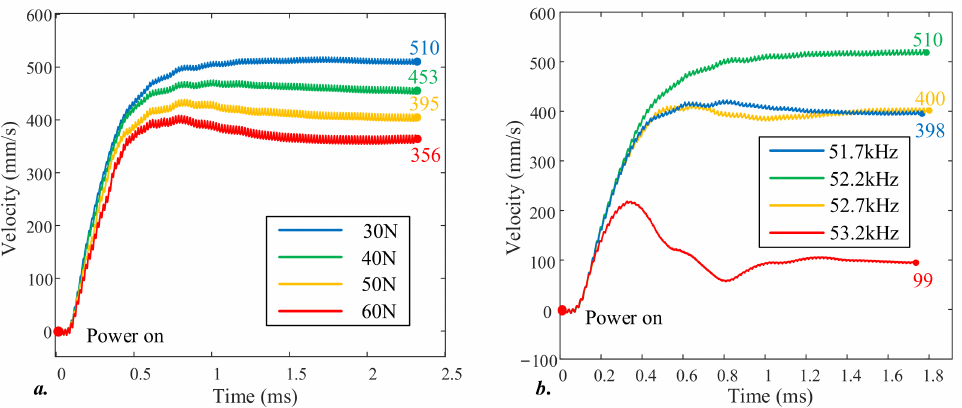
Figure 11. The velocity-time curve of the traveling wave LUSM by simulations: ( a ) the velocity-time curves with different preloads; ( b ) the velocity-time curves with different